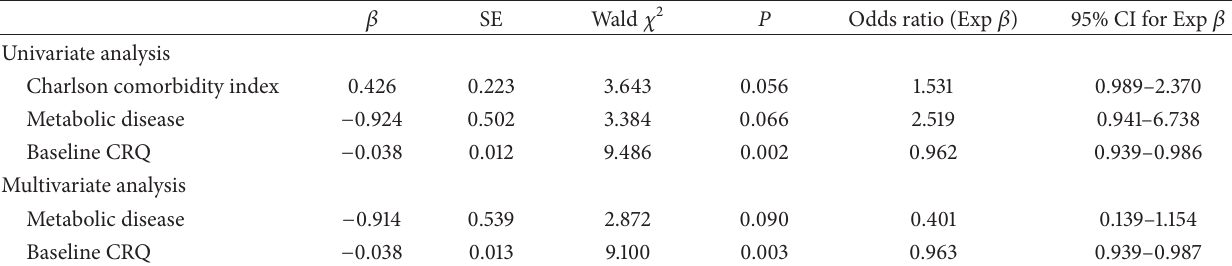
Table 4: Binary logistic regression model for a responder in the Chronic Respiratory Questionnaire (CRQ). 𝛽 SE 95% CI for Exp